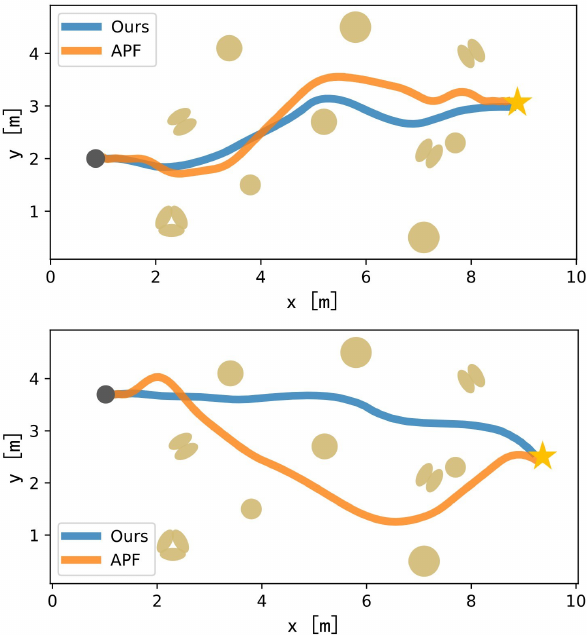
Figure 17. Trajectories in the static